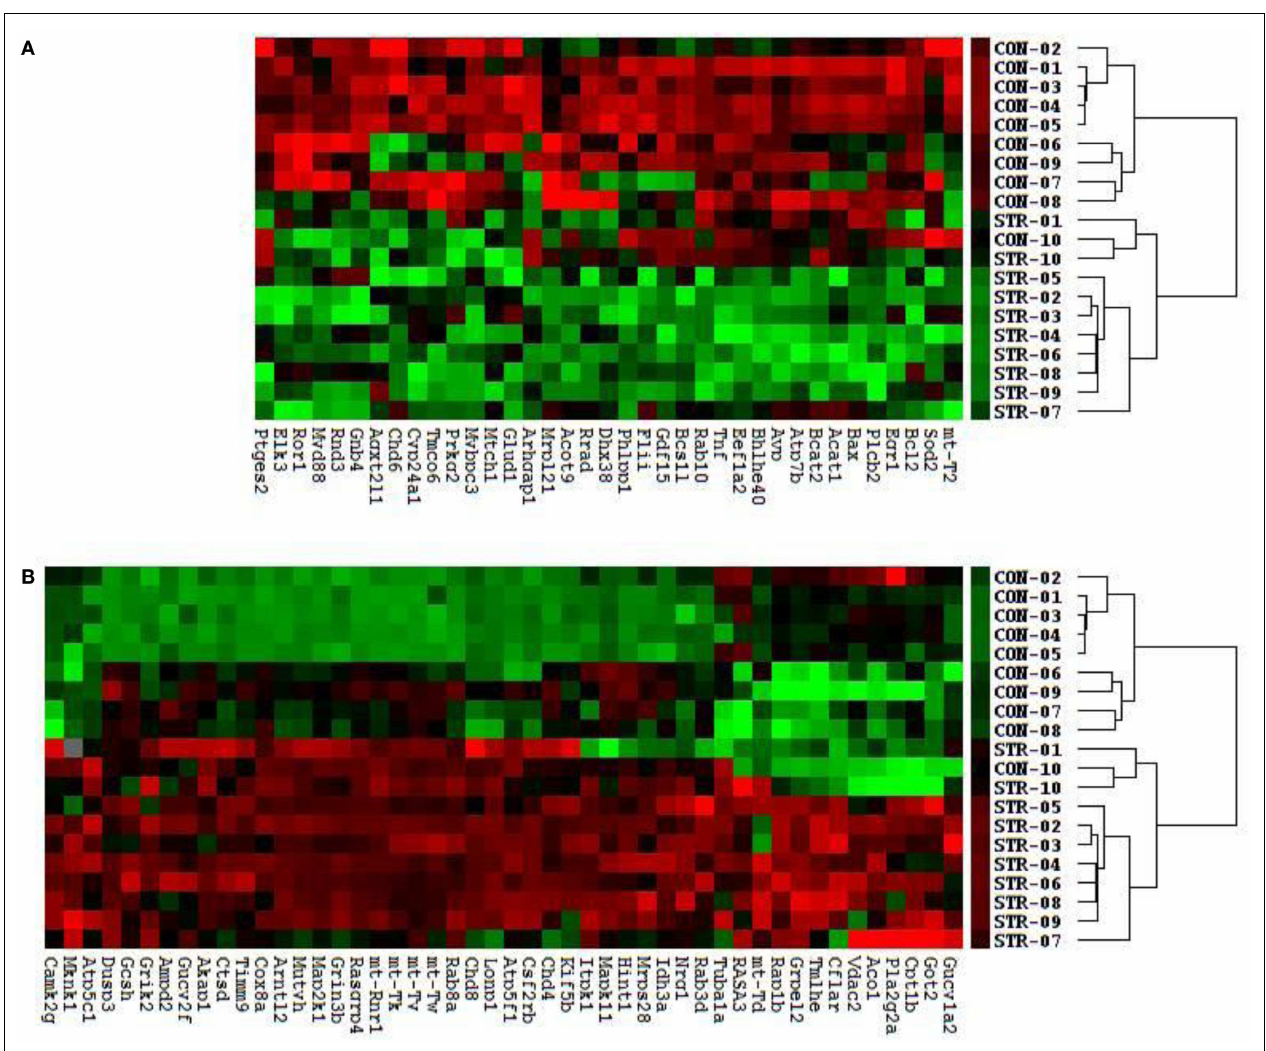
calculated between the stressed ( n = 10) and control specimens ( n = 10), resulting in the identification of 85 genes ( p < 0.01) and among these 55 altered genes ( p < 0.01) were further selected using a high stringency algorithm that includes fold change and fault discovery rate in the stressed amygdala as compared to the controls ( Tables 1 and 2